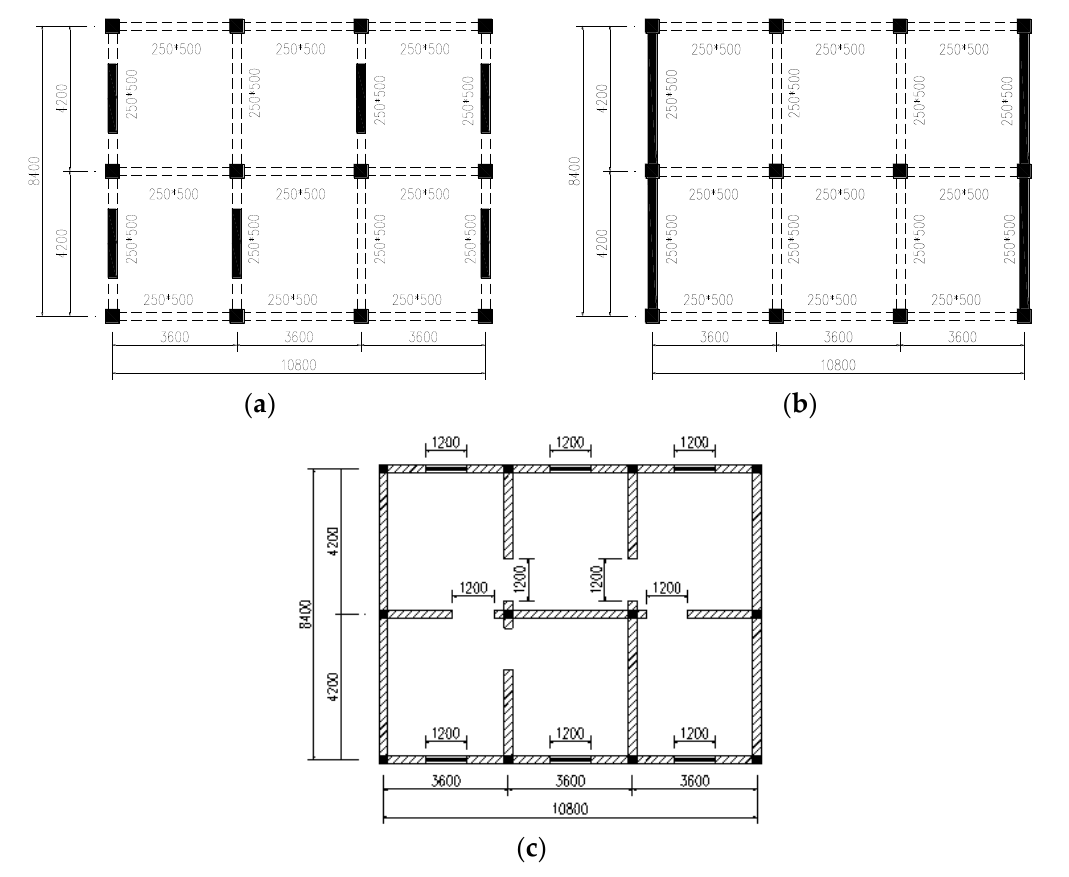
Figure 15. Structure plane layouts. ( a ) JG-1 plane layout of CFST damper on the first story; ( b ) JG-2 and JG-3 plane layouts of shear wall on the first story; ( c ) plane layout of the second to fifth floors of three structures.